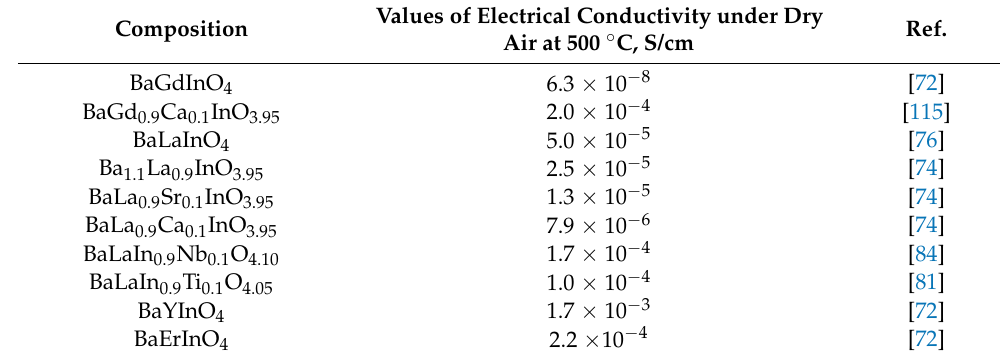
Values of Electrical Conductivity under